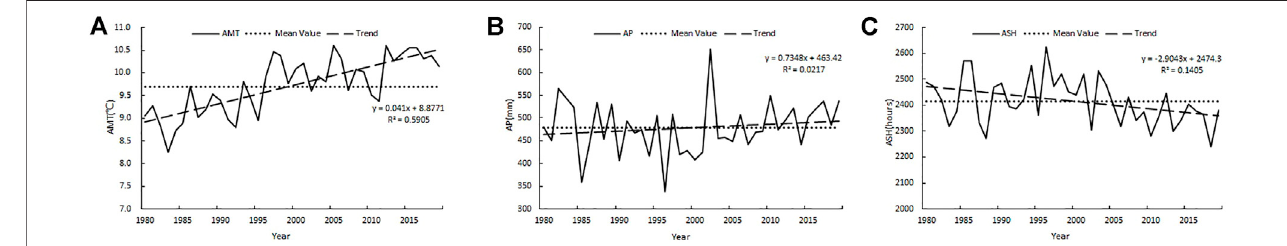
FIGURE 3 | Inter-annual variation of the AMT (A) , AP (B) , and ASH (C) in the Yellow River